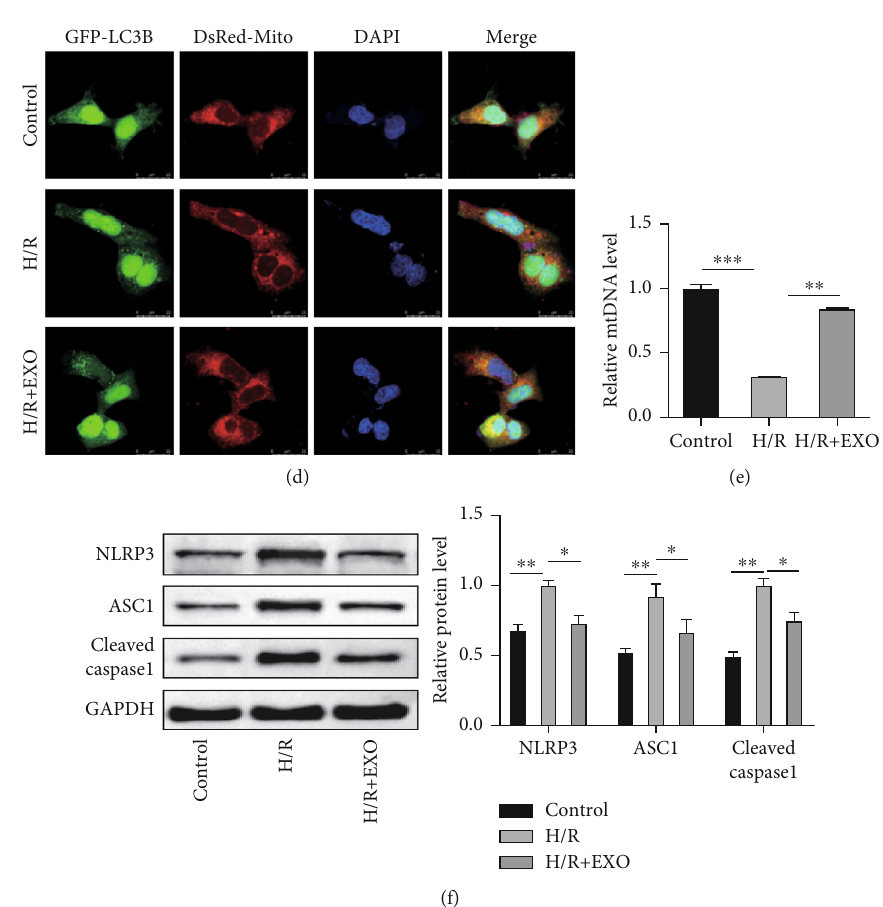
Figure 3: BMSC-derived EVs suppressed apoptosis and in fl ammasome activation and promoted mitophagy in H/R-induced TCMK-1 cells. TCMK-1 cells were subjected to H/R stimulation and exosome treatment. (a) The H/R-induced cell apoptosis was determined using fl ow cytometry. (b and e) The protein levels of BAX, cleaved caspase-3, and Bcl-2 were con fi rmed using the western blot analysis. (c) Expressions of the mitophagy markers were detected using the western blot analysis. (d) Mitophagosome formation was assessed based on the colocalization of the autophagy marker GFP-LC3B and the mitochondria marker Mito Tracker (DsRed-Mito). (e) The levels of mitochondrial DNA (mtDNA) were determined using qPCR. (f) The expressions of NLRP3, ASC1, and cleaved caspase 1 were evaluated using the western blot analysis. N = 3 . ∗ P < 0 : 05 ; ∗∗ P < 0 : 01 ; ∗∗∗ P < 0 : 001